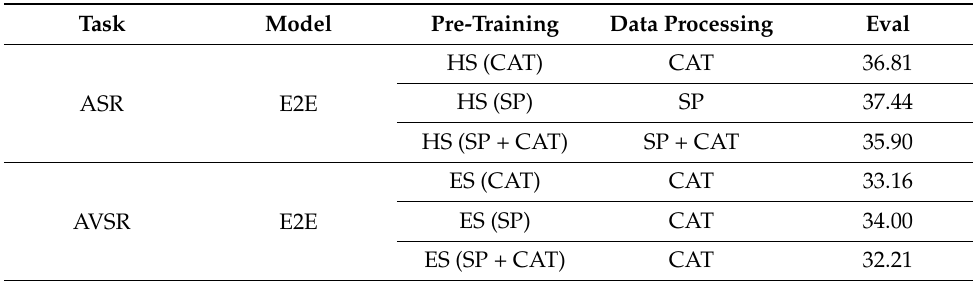
Table 2. The results (CER %) of the ES pre-training. HS and ES mean the hybrid system and end-to- end system, respectively. CAT and SP mean splicing the continuous segments and speed perturbation, respectively.